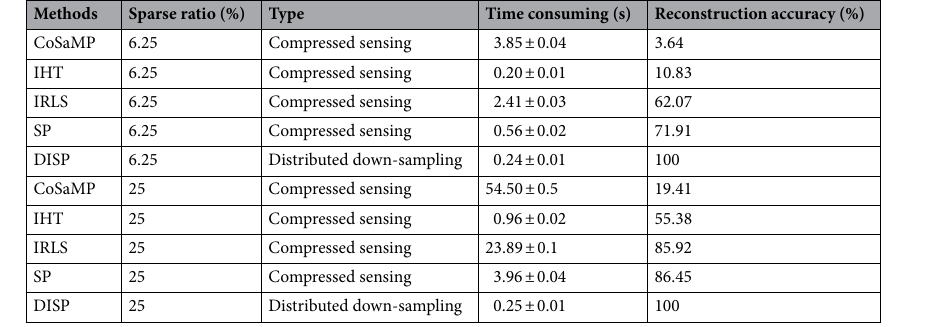
Table 2. Performance of different